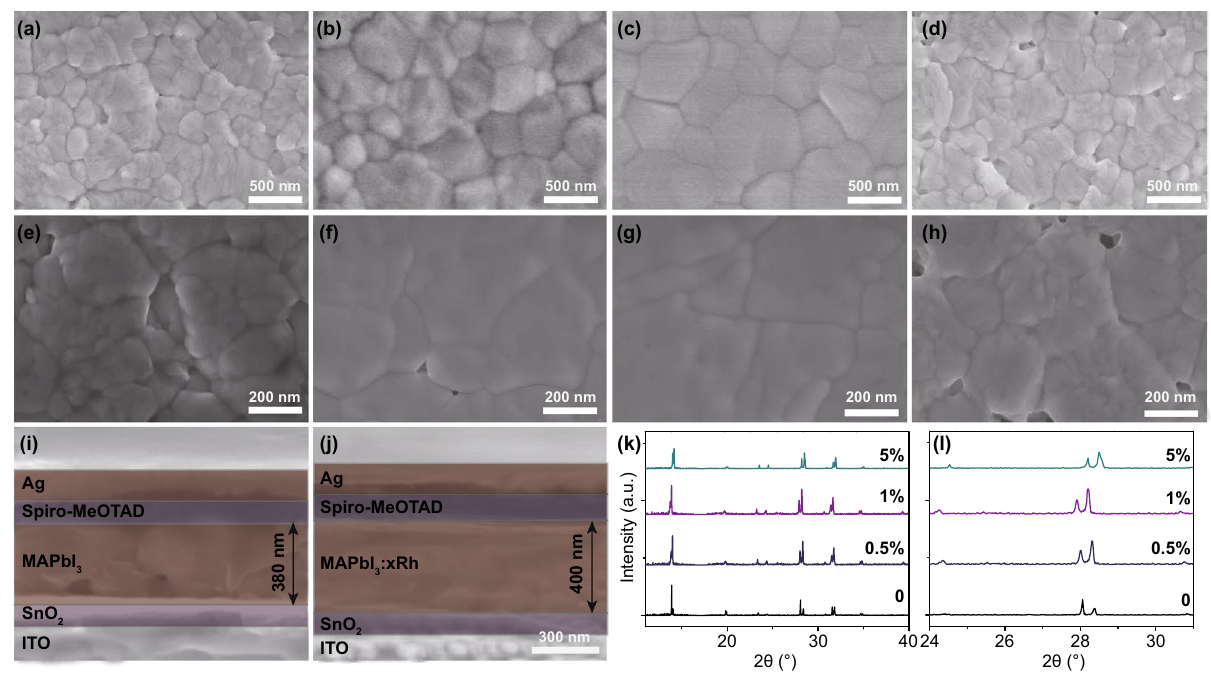
Fig. 1 SEM pictures of MAPbI 3 : x Rh [where x = 0 ( a , e ), 0.5% ( b , f ), 1% ( c , g ) and 5% ( d , h )] films. i , j Cross‑sectional pictures of PSCs fabri‑ cated by MAPbI 3 : x Rh (where x = 0, 1%). k , l XRD patterns of the MAPbI 3 : x Rh single crystal (where x = 0, 0.5%, 1% and